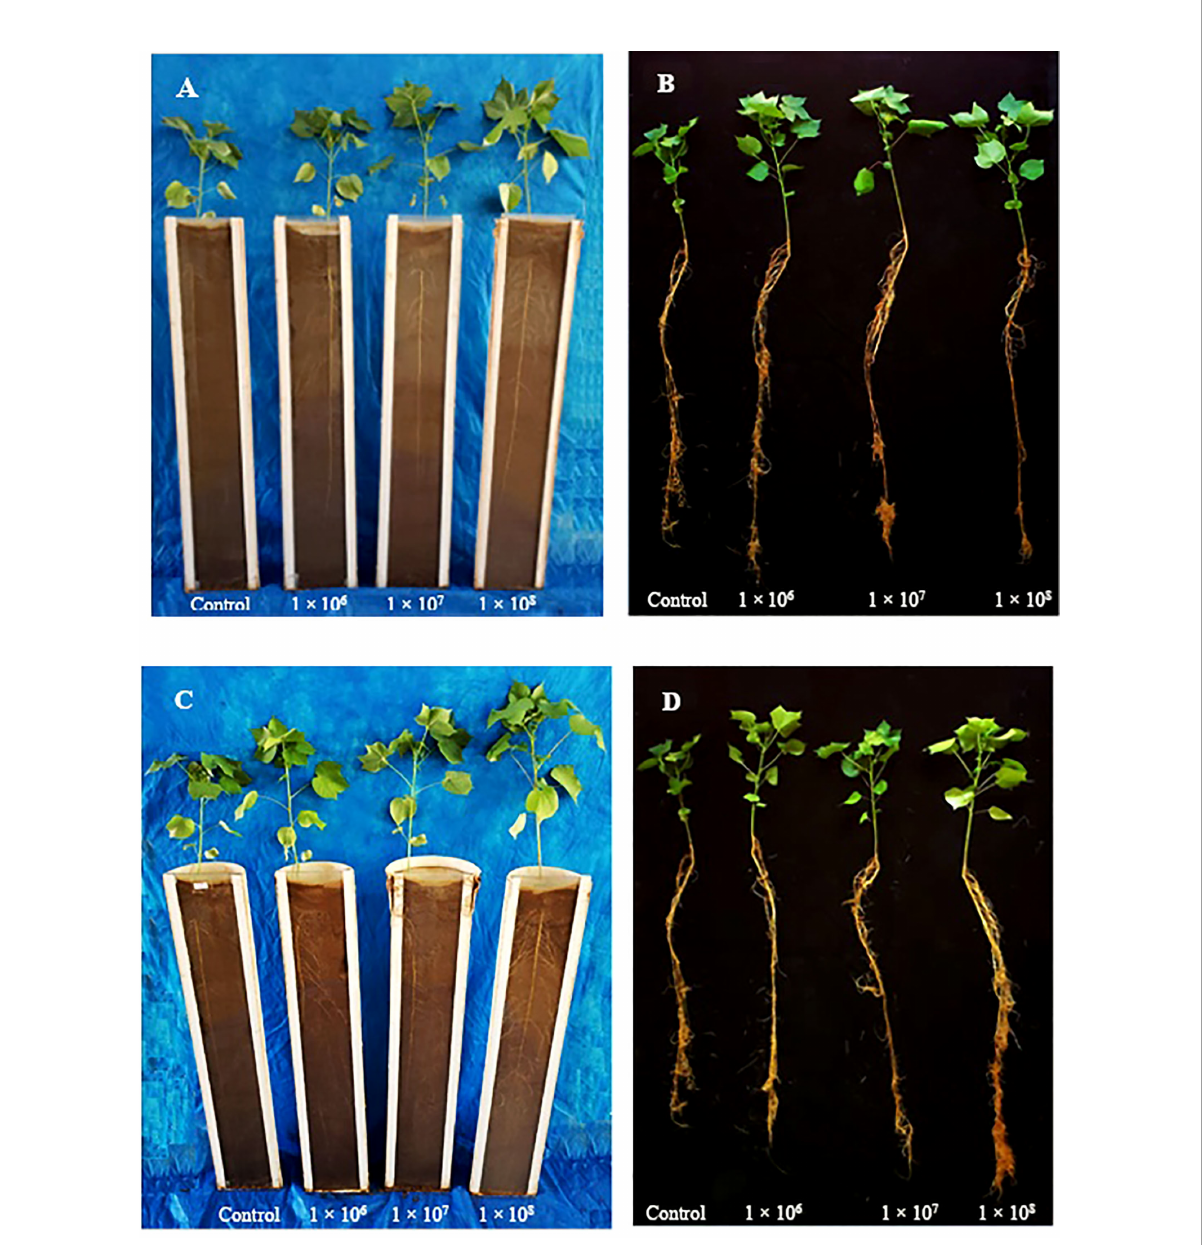
FIGURE 4 Cotton plants treated with Trichoderma asperelloides CMAA 1584 (A, B) and Trichoderma lentiforme CMAA 1585 (C, D) after 60 days of sowing in